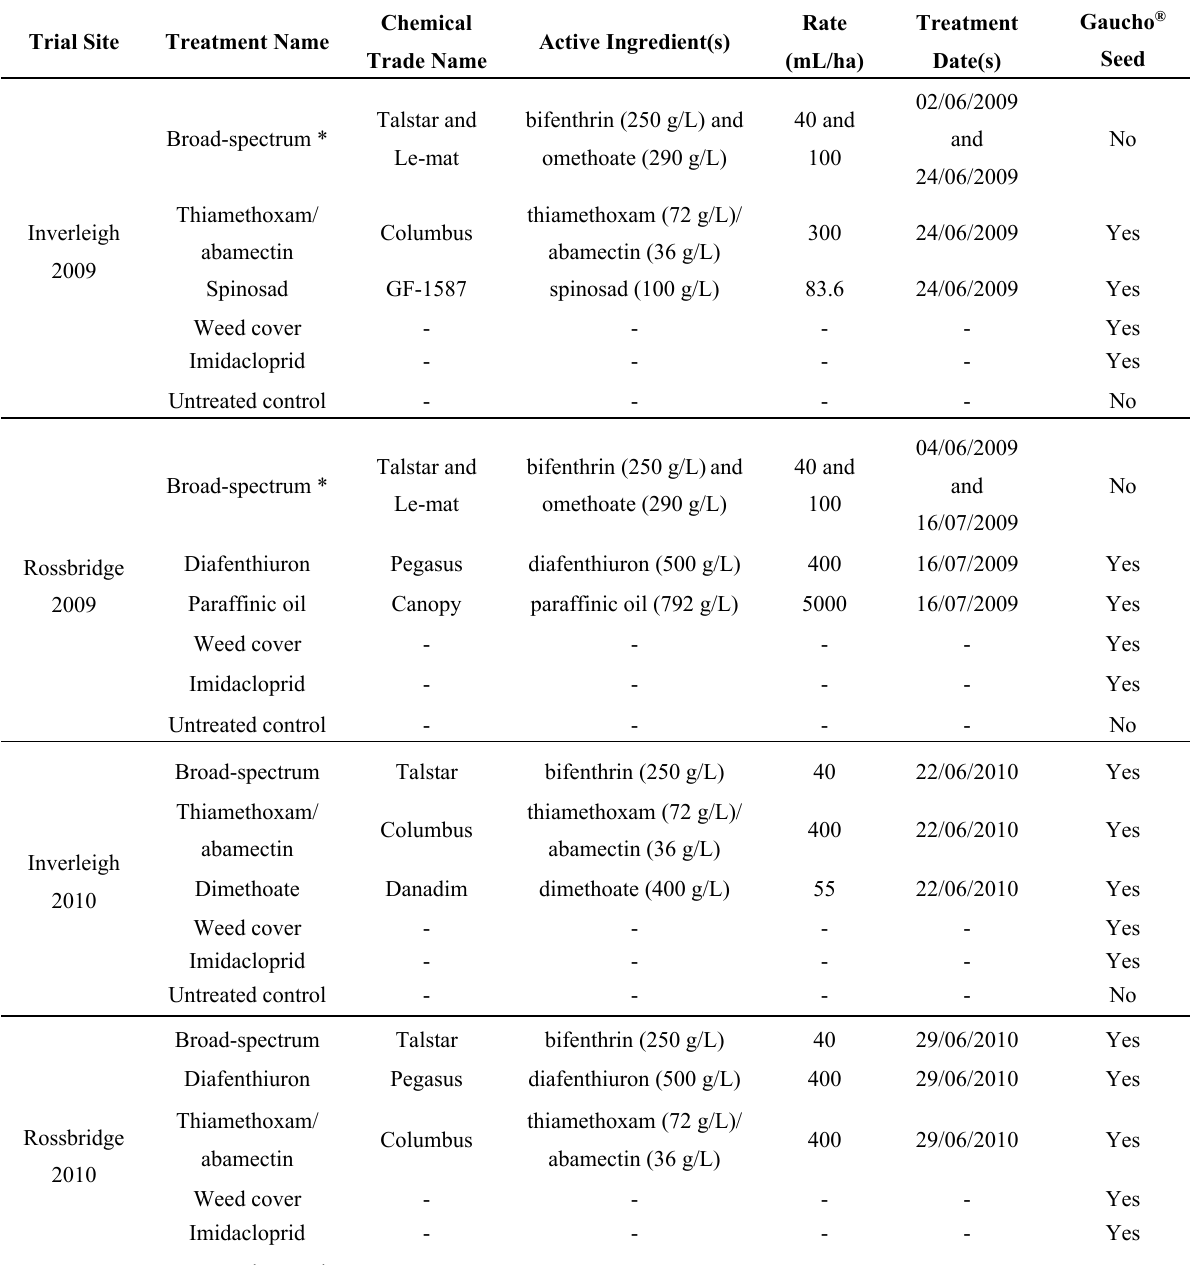
Table 1. Chemical treatments applied at each trial